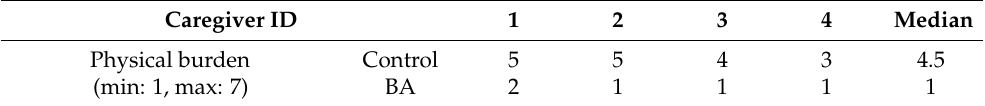
Table 4. Results of the questionnaire on the physical burden on caregivers.